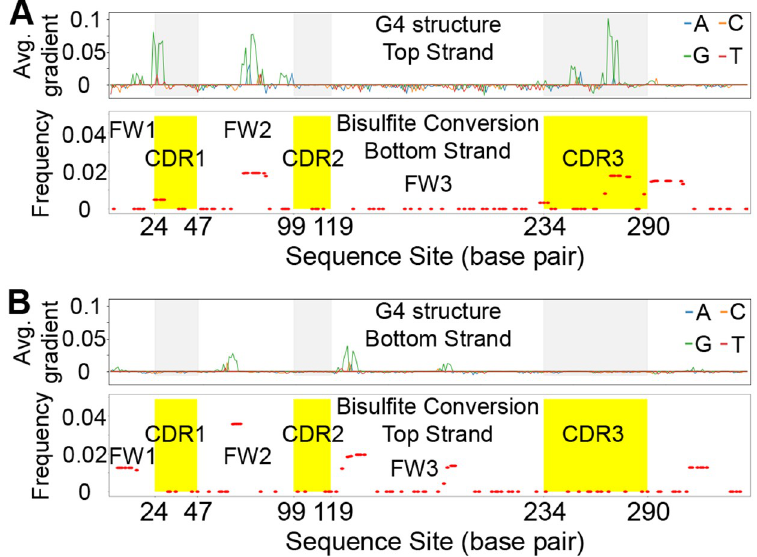
Fig 4. The potential spatial correlation between BAR and DNA G-quadruplex structure in IGHV4–34 gene in Ramos. (A) The sites having potential G4 structure in the top strand colocalize with the sites having BARs in its corresponding bottom strand. Top panel shows the position of the predicted G4 structures in top strand. X-axis is the nucleotide position of IGHV4–34 gene and Y-axis represents the average gradient of the predicted G4 structure in each site. The regions with gray background are CDR1, CDR2 and CDR3 from left to right. Different colors represent individual bases that contribute to the predicted G4 potential. The bottom panel shows all the BARs from different clusters together. Y axis represents the frequency of BARs in each position. The regions with yellow background are CDR1, CDR2 and CDR3 from left to right. (B) The correlation between predicted G4 structure on bottom strand and the BARs in its corresponding top